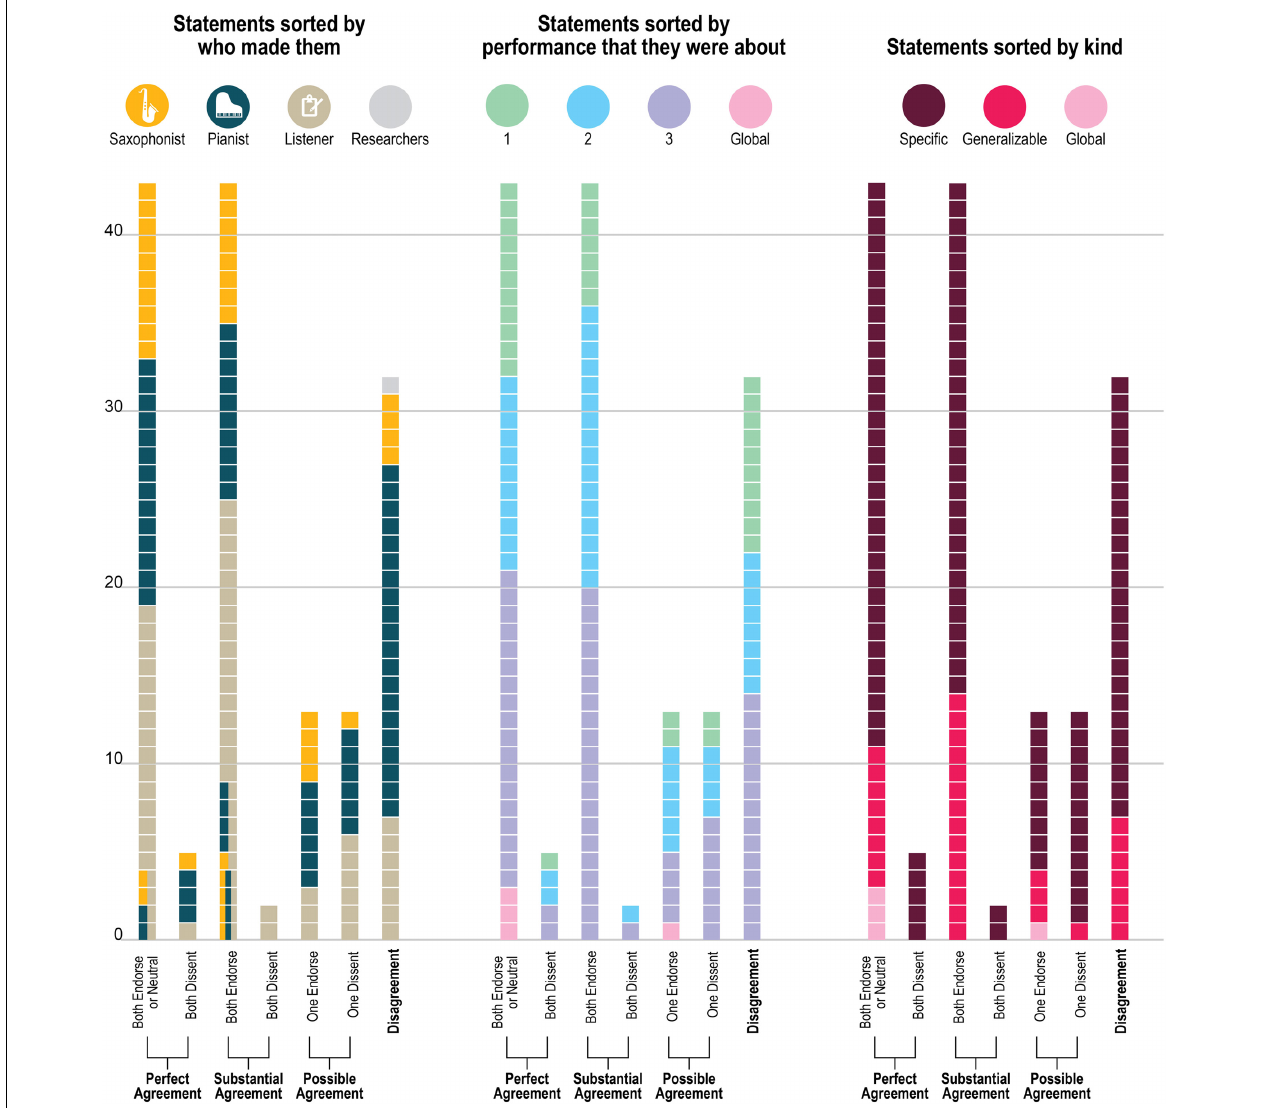
FIGURE 4 | Distribution of players’ agreement for the 151 unique statements. “Perfect agreement” means that both players gave exactly the same rating (from 1 to 5 on the 5-point scale); “substantial agreement” means that both players’ ratings differed by only 1 point and they were either